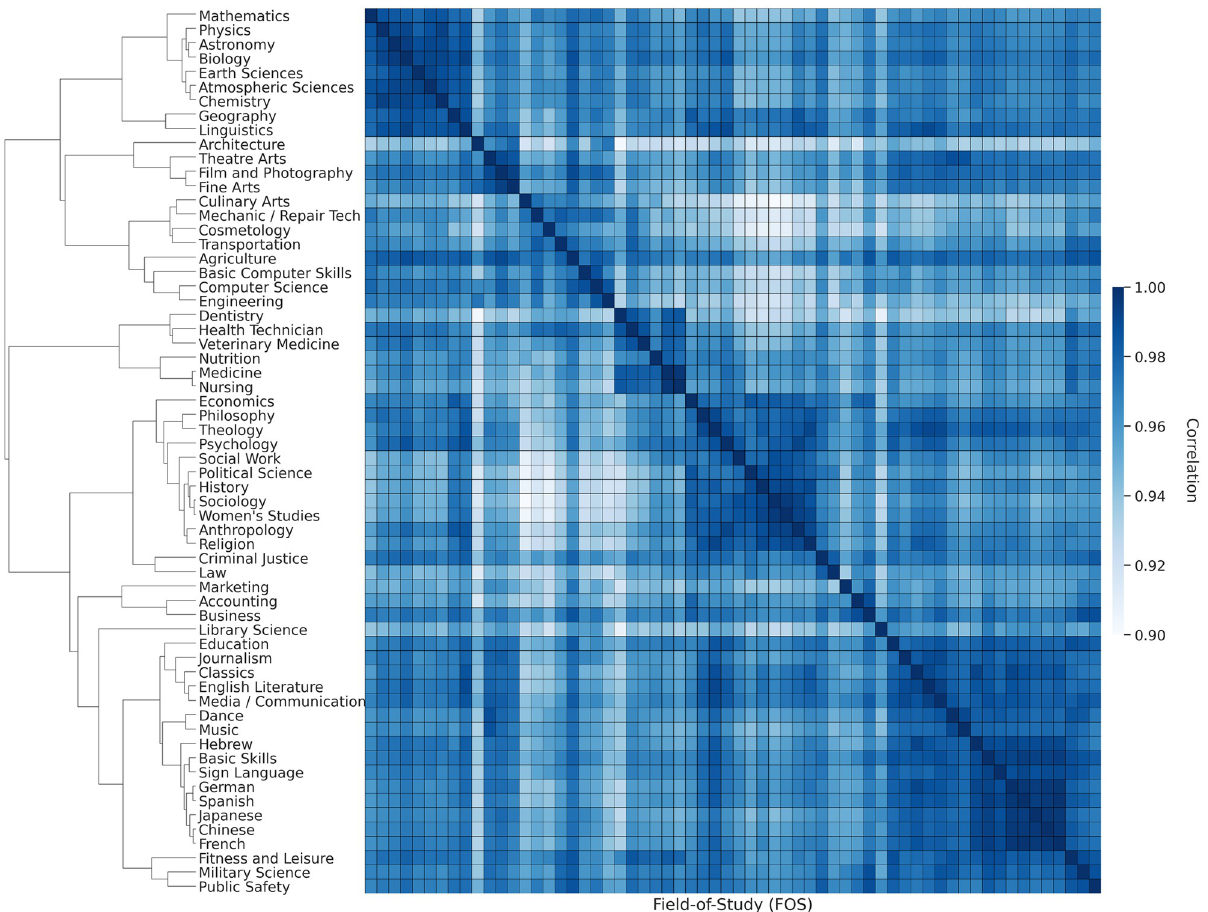
Fig 2. The similarity of FOS based on the prevalence of DWAs in syllabi from within those fields. The dendrogram and heatmap show similar FOS clustered together based on their DWA-vector